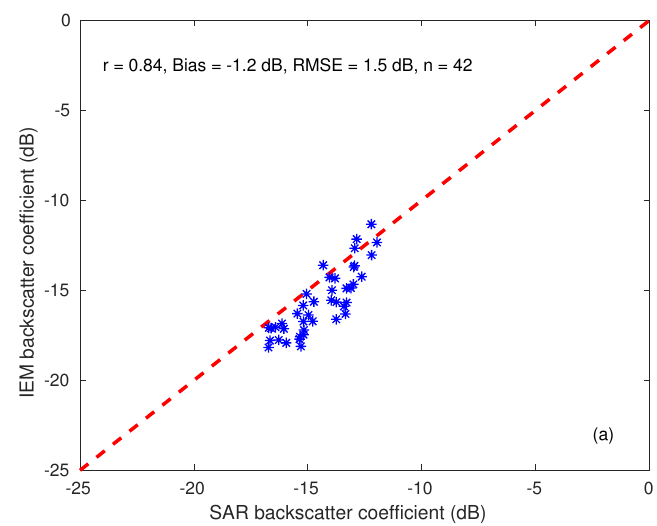
Figure 5. Comparison between backscattering coefficients derived from Sentinel-1 images and those simulated by the IEM model at VV polarization using measured L .